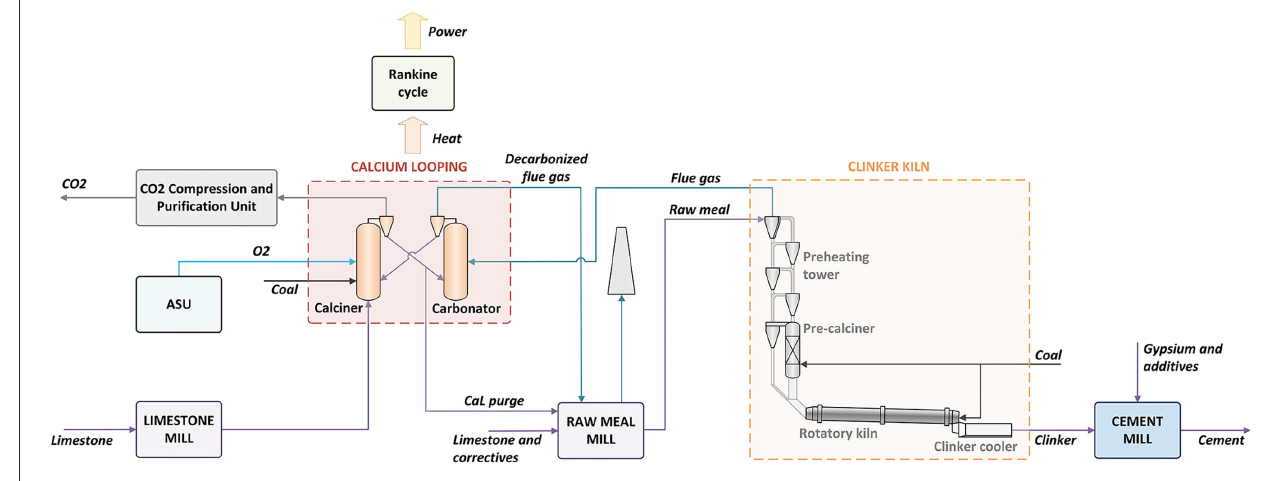
FIGURE 3 | Calcium looping tail-end